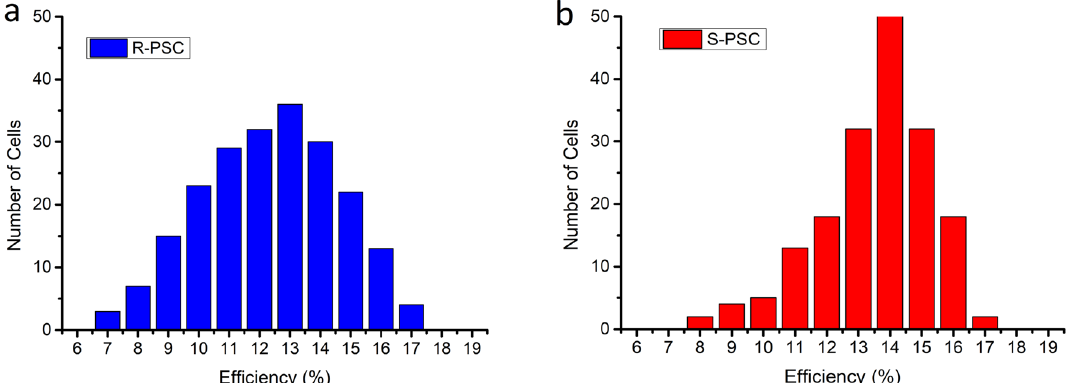
Figure 4. Average efficiency distribution of ( a ) reference ( b ) sepiolite included PSCs.